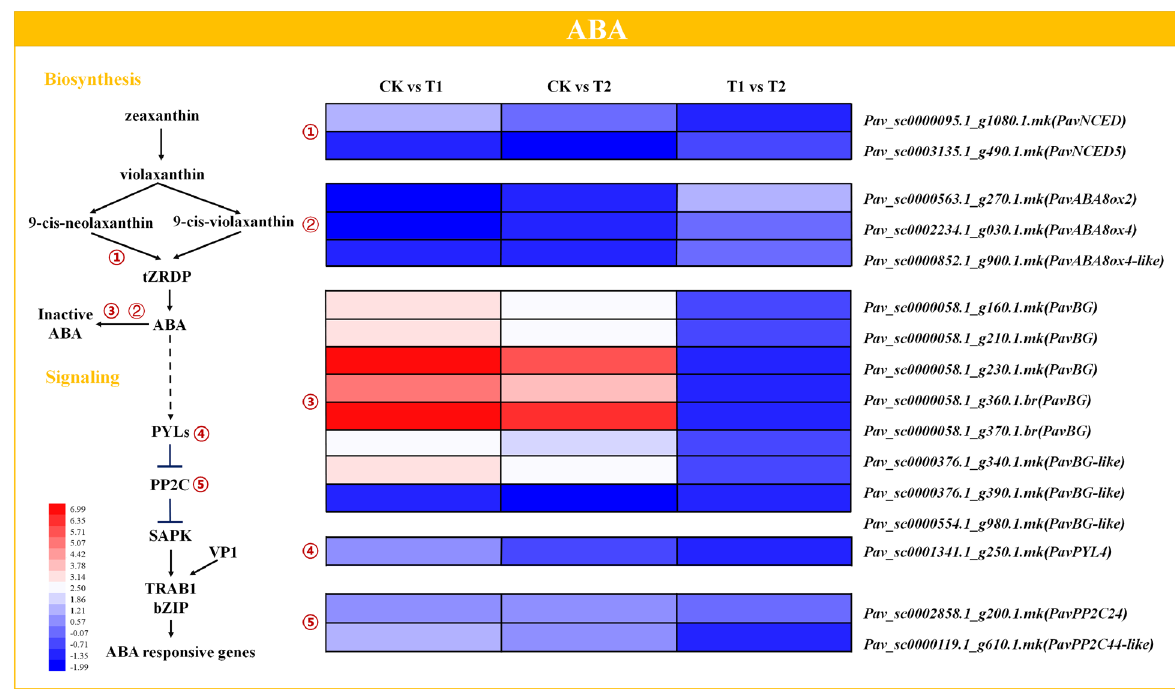
Fig. 8 Expression profiles of differentially expressed genes related to ABA biosynthesis and signaling pathways, shown using a heatmap. The scale of color intensity is in the lower left quarter of heatmap, representing the log 2 fold-change values. Fold-change refers to the ratio of gene expression level in cherry rootstock leaves between control (CK) and treatments